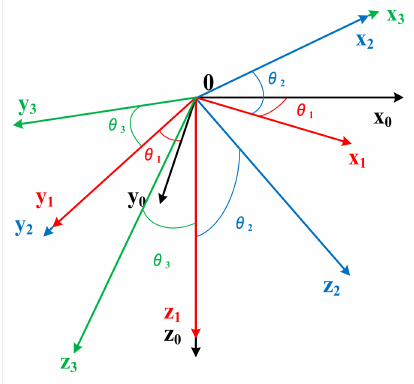
Figure 2. Relative motion of each coordinate